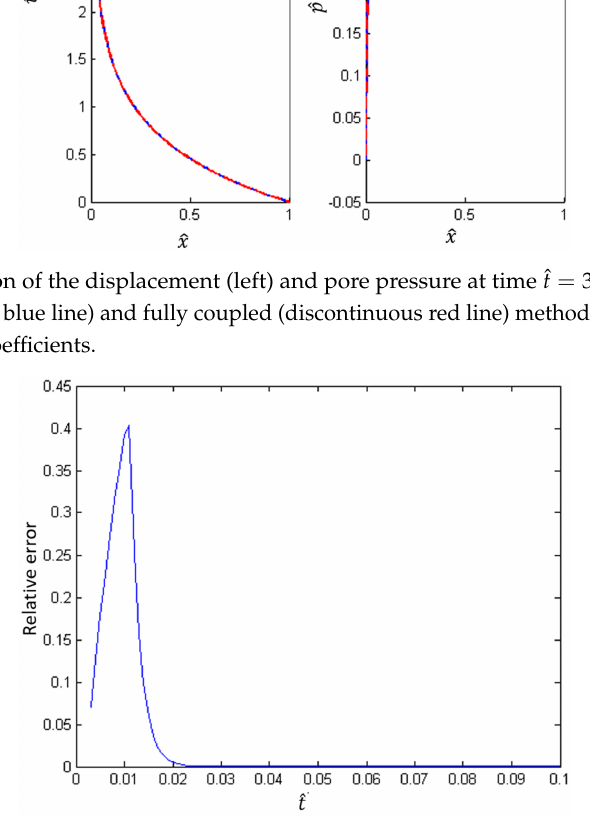
Figure 6. Error propagation of hybrid splitting method with only one iteration for linear material coefficients.